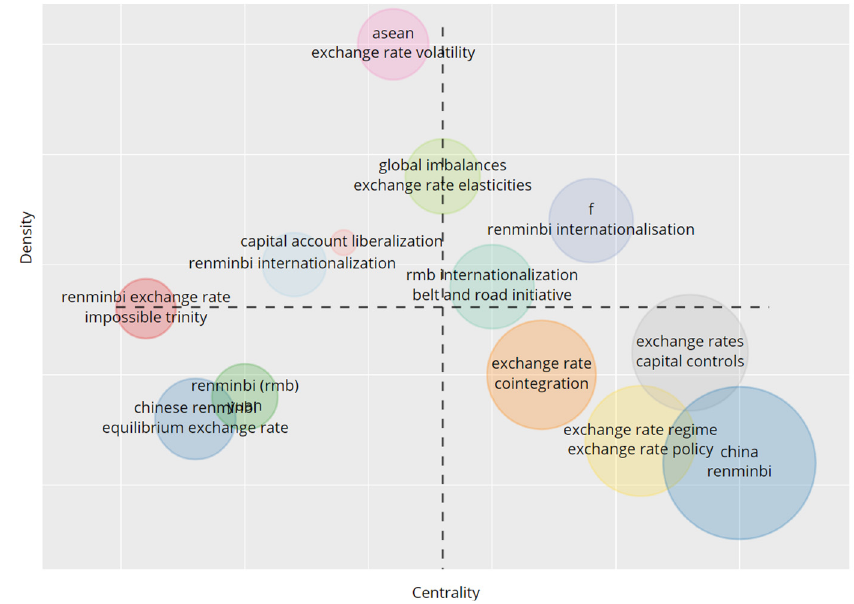
Figure 8. Thematic map of the renminbi literature. Source: Authors’ elaboration using Biblioshiny.